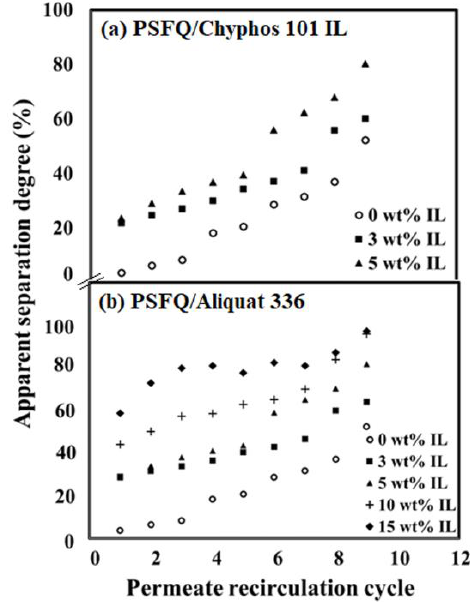
Figure 7. Apparent separation coefficient developed by the studied membranes, obtained from PSFQ/Chyphos 101 IL ( a ) and PSFQ/Aliquat 336 ( b ) blends, in the treatment process of waters containing 3 mg·L −1 DCF.